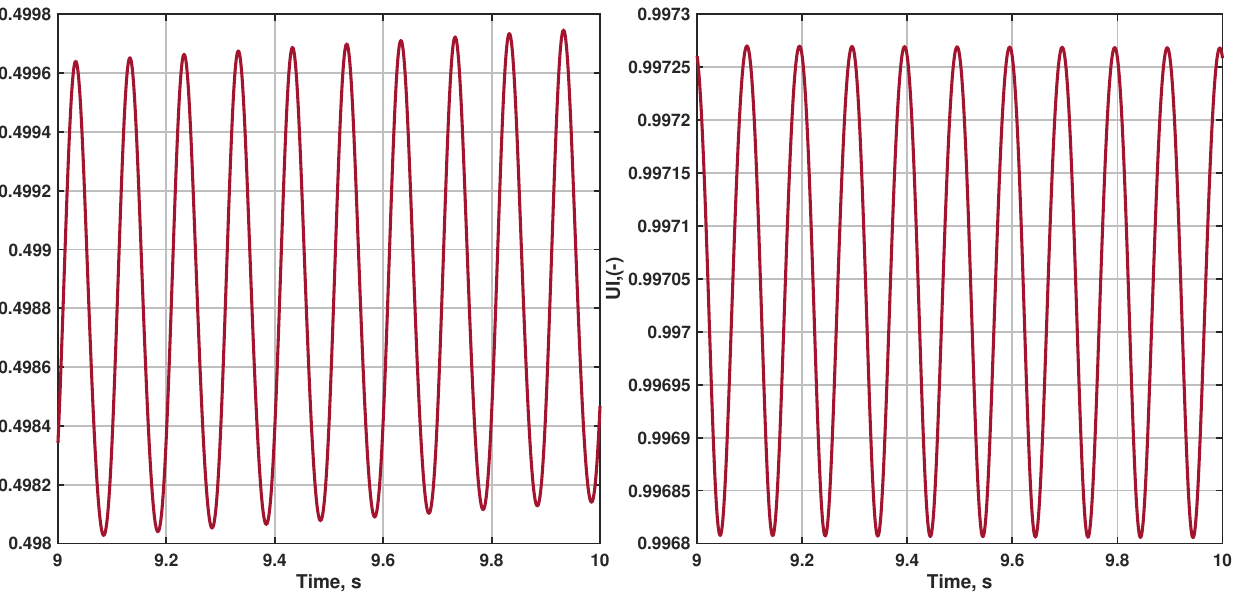
Figure 12. Resulting conversion at the system outlet ( left ) and uniformity index of the reactant field ( right ) over time as obtained in case 1C, where the inlet velocity is constant but temperature is